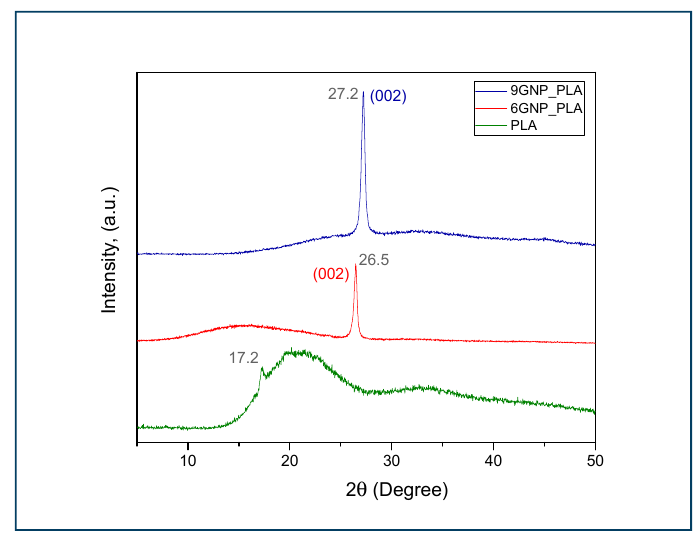
Figure 6. X–ray diffraction of nanocomposites with rising graphene concentration and neat PLA as a reference.